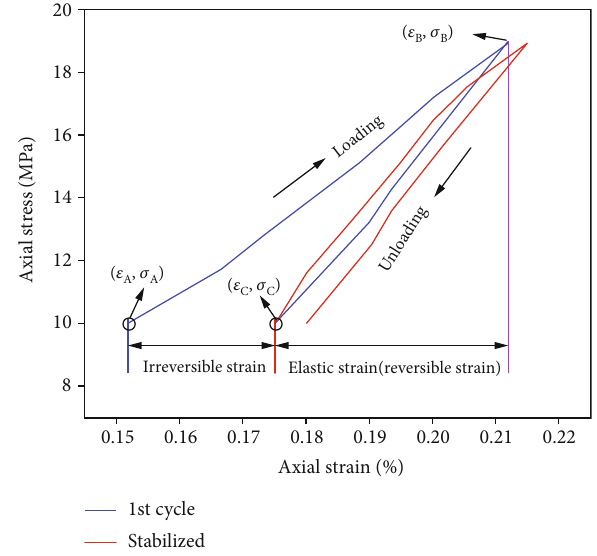
Figure 6: Tangential elastic modulus calculation method in each hysteresis